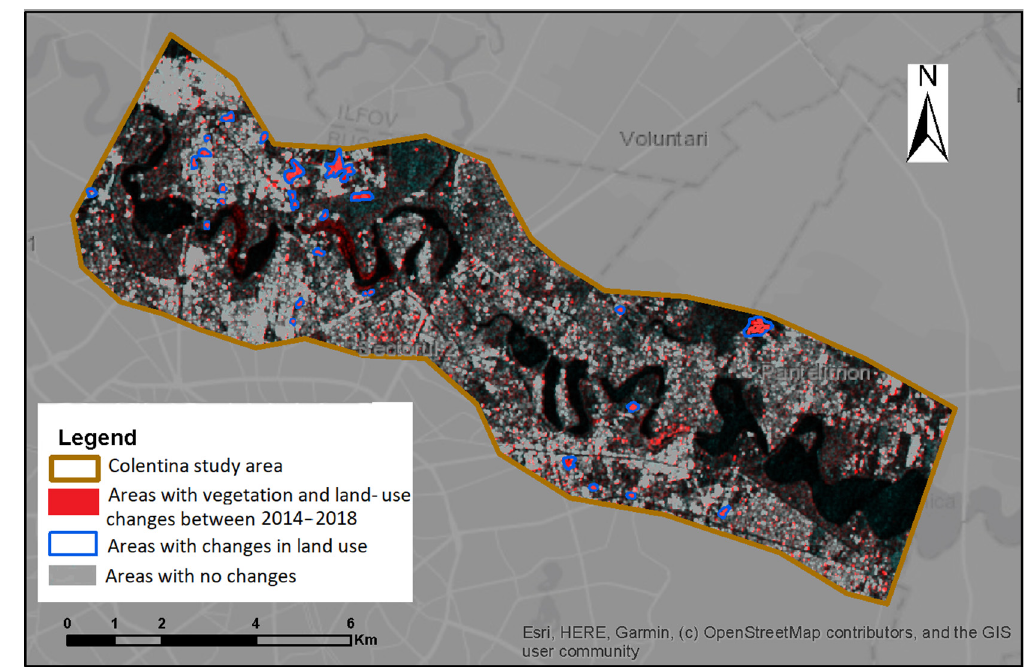
Figure 7. Land-cover changes for the Colentina River buffer zone modified after [28]. Map generated in Esri ® ArcMap™ 10.3. Base map source: ESRI. Source: elaborated by the authors. in Esri ® ArcMap™ 10.3. Base map source: ESRI. Source: elaborated by the